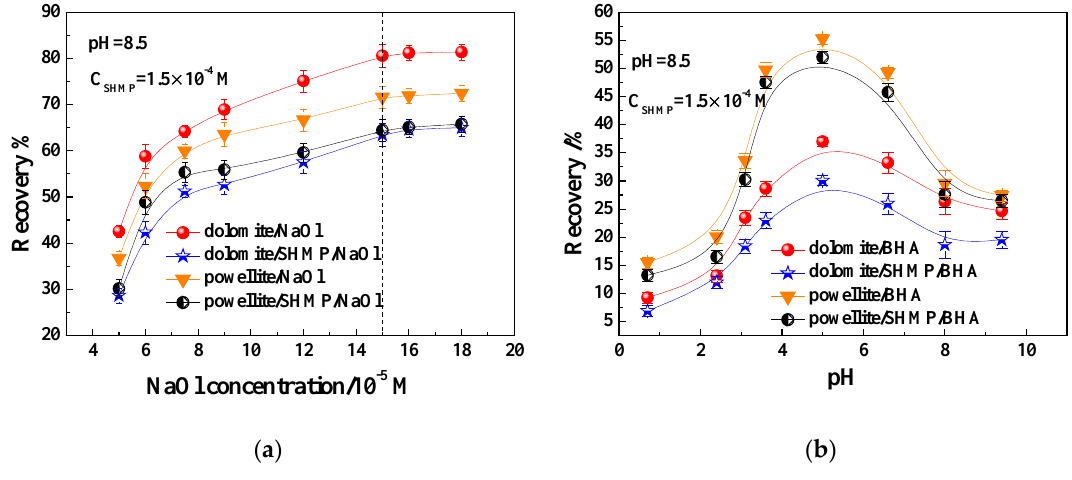
Figure 3. Effects of ( a ) NaOl and ( b ) BHA dosages on the flotation of minerals with and without sodium hexametaphosphate (SHMP).